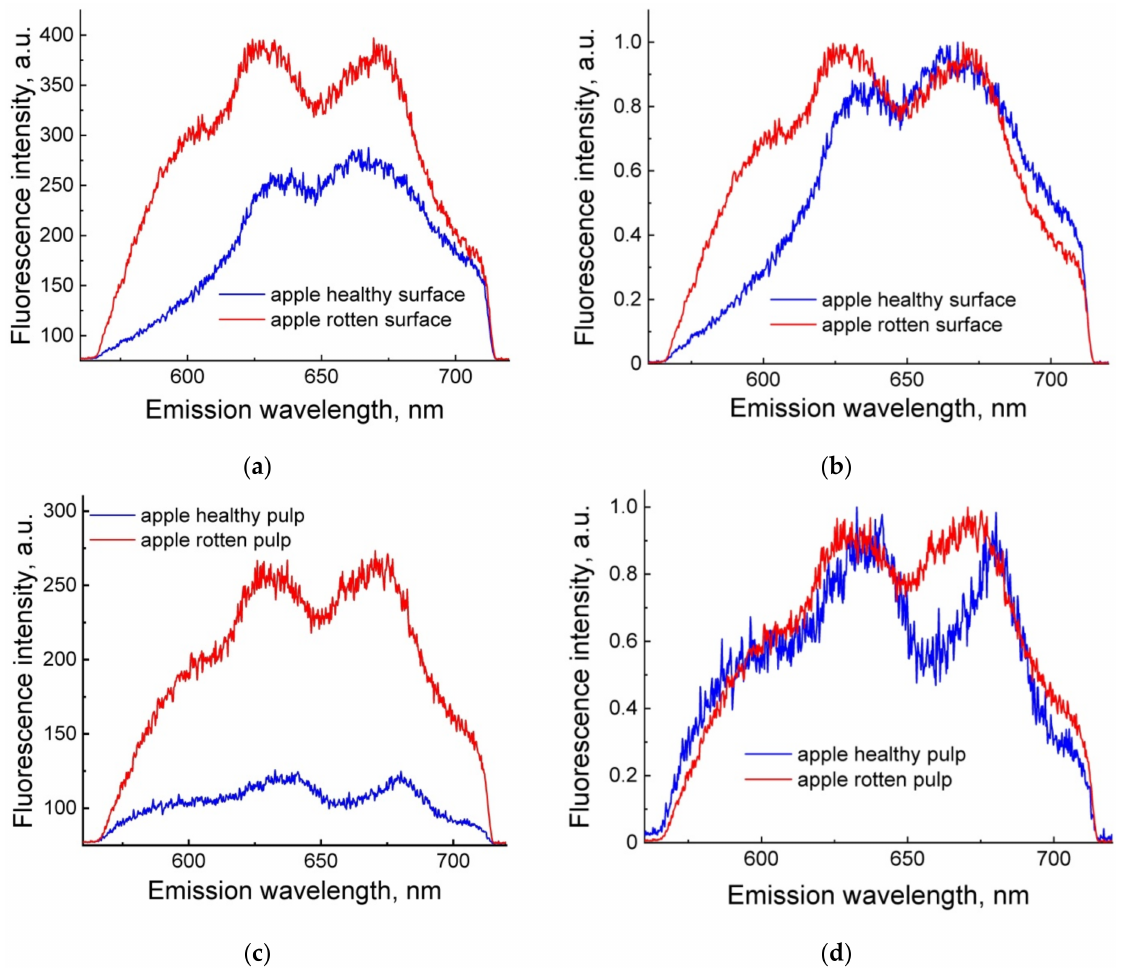
Figure 8. Pulsed fluorescence spectra of healthy (black) and rotten (red) red apples: ( a ) initial spectra of surfaces; ( b ) normalized spectra of surfaces; ( c ) initial spectra of pulp; ( d ) normalized spectra of